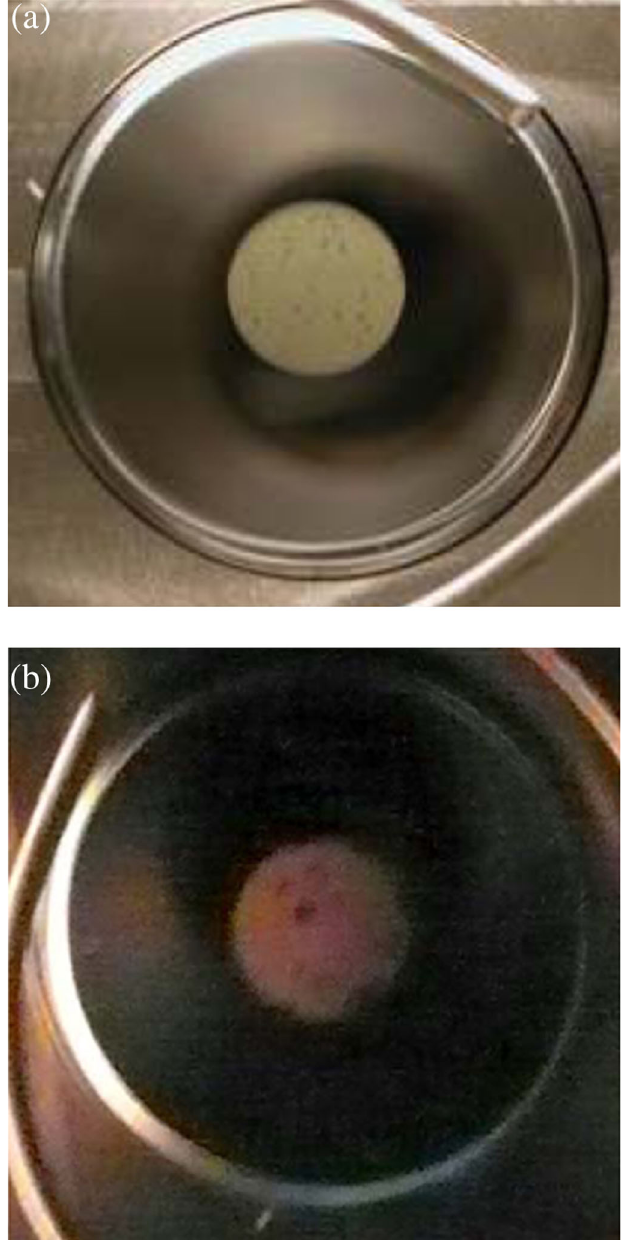
FIG. 14. (Color) Survey spectra measured at photon energy of #92.1).FIG. 13. (Color) Photographs of Cs Te photocathode #90.1 be- 900 eV for fresh cathodes (red: #42.3; magenta: #90.1) and used 2 fore (a) and after (b) use in the cathodes (blue: #34.6; black: